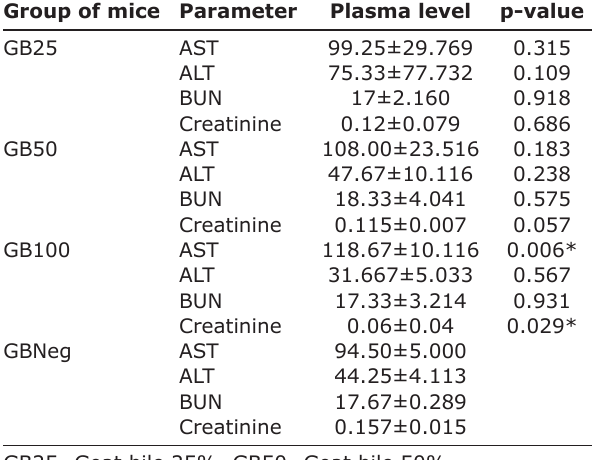
Table-2: Blood biochemistry in mice treated with goat bile compared with negative control.